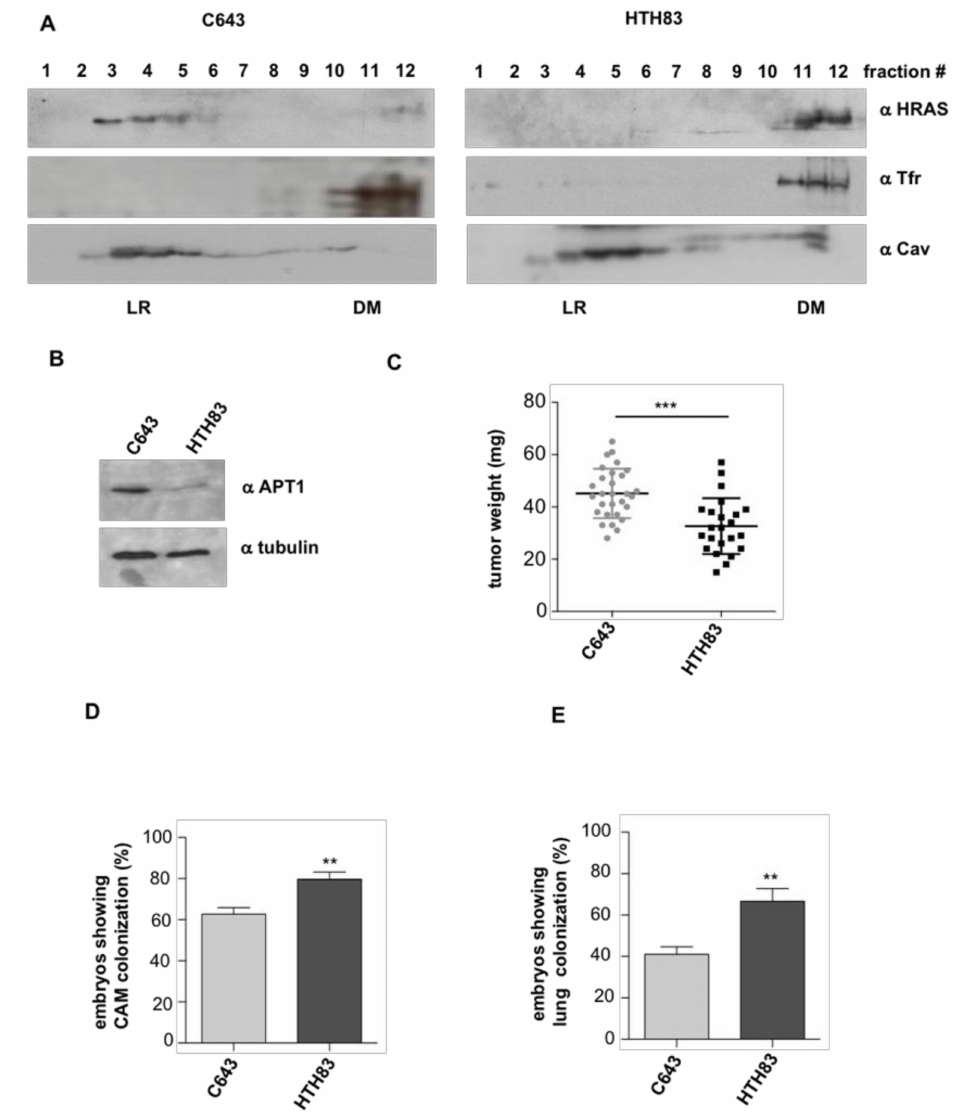
Figure 3. HRAS distribution in plasma membrane (PM) microdomains is related to tumor behavior. ( A ) Endogenous HRAS localization at LR and DM fractions in the indicated cell lines. Caveolin-1 (Cav) and transferrin receptor (Tfr) serve as specific markers for their respective microdomains. ( B ) APT-1 expression levels in the indicated cell lines. ( C ) Size of the tumors generated by the indicated cell lines when grafted (10 6 cells) on chick embryos. ( D ) Intravasation, expressed as the % of chicken displaying distal CAM colonization. ( E ) Distant metastases, expressed as the % of chicken displaying lung colonization. Data show mean ± SD ( C ); mean ± SEM ( D , E ) from three independent experiments using 8–16 embryos per case. ** p < 0.01 and *** p < 0.001 by two-tailed unpaired Student t